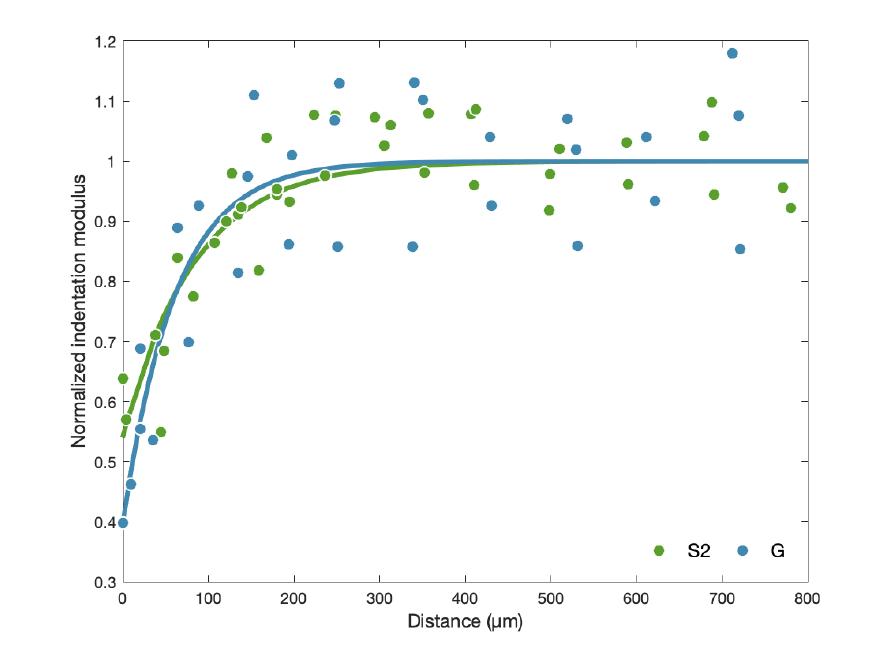
Figure 7 : Normalized indentation modulus of the S 2 and G-layers from Fig. 6 as a function of the distance from the cell where the layer concerned first appeared. The solid line corresponds to the mean